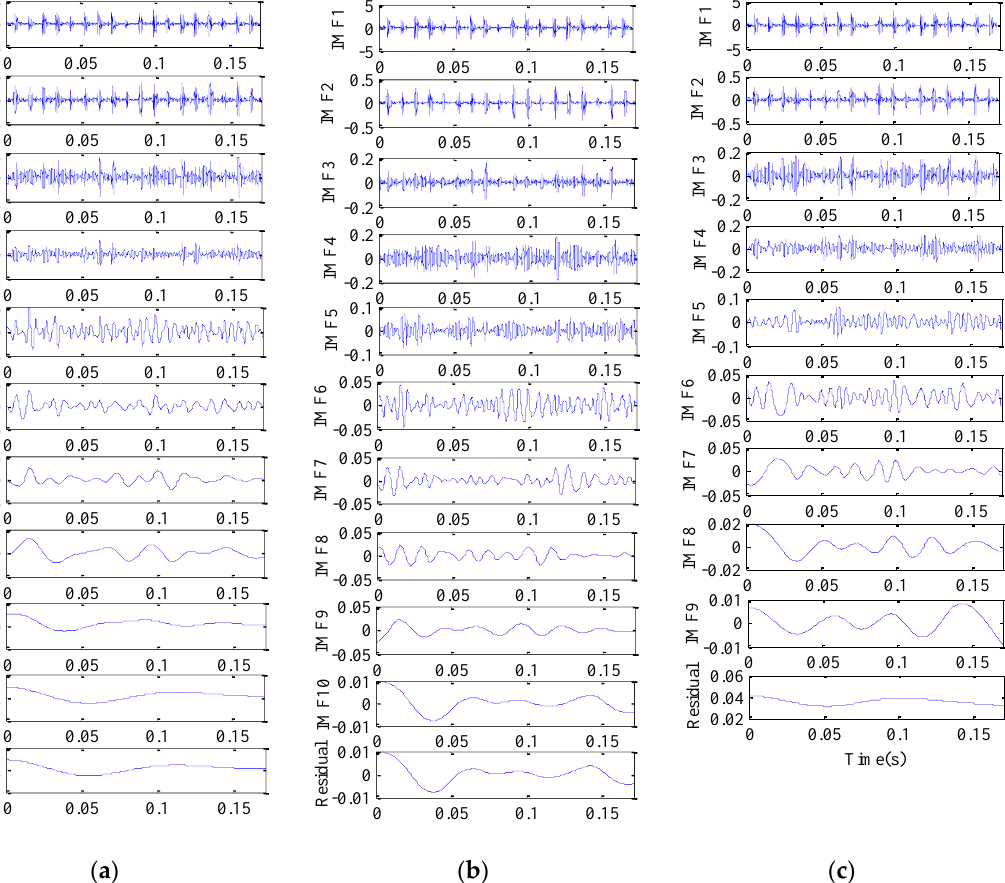
Figure 4. Decomposition results for one vibration signal sample of bearing fault class 7 by ( a ) ensemble empirical mode decomposition (EEMD), ( b ) complete ensemble empirical mode decomposition with adaptive noise (CEEMDAN), ( c ) and improved CEEMDAN (ICEEMDAN).